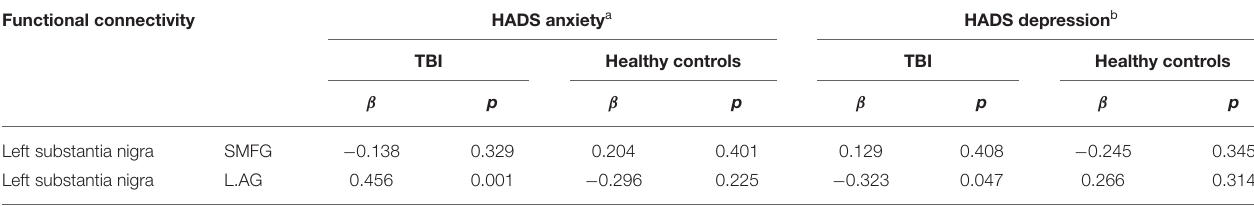
TABLE 3 | Associations of left SN functional connectivity with anxiety and depressive symptoms in patients with TBI and healthy controls. Functional connectivity HADS anxiety a HADS depression b TBI Healthy controls TBI Healthy